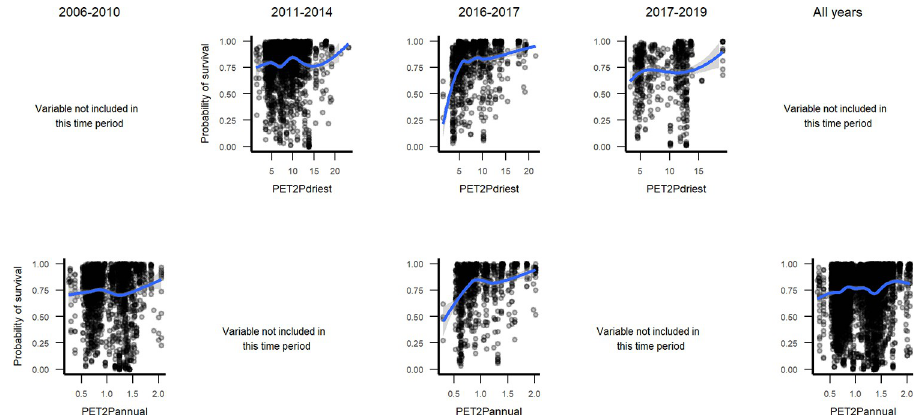
Fig 8. Marginal plots through time of long-term potential evapotranspiration to precipitation ratio for the year (PET2Pannual) and the driest quarter (PET2P driest). This index is inversely related to aridity.